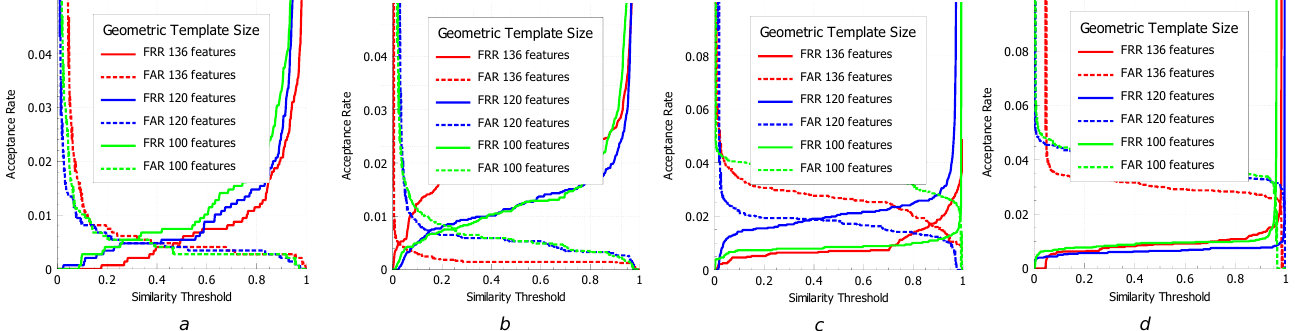
Figure 9. FAR/FRR of ANN classifier for various various compression of geometric features (PCA components): ( a ) Print/Capture Aberdeen; ( b ) Print/Capture Aberdeen v2; ( c ) Print/Capture Utrecht; and ( d ) Print/Capture